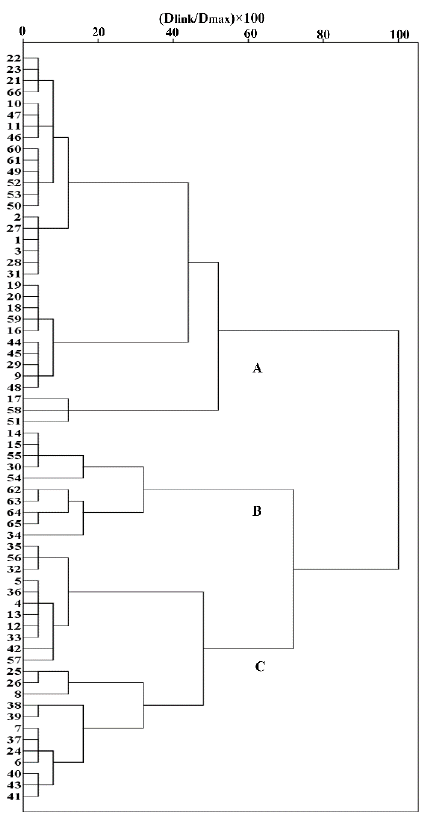
Figure 3. Dendrogram showing the spatial similarities of the sampling sites produced through cluster analysis. Note: A, B and C represent different group of sampling sites.